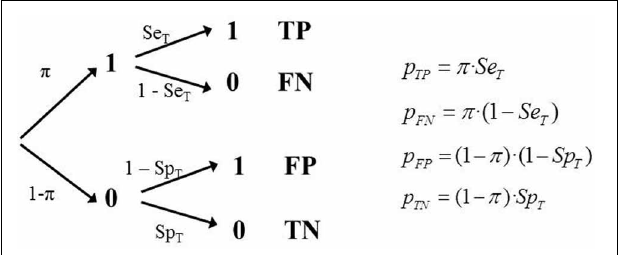
FIGURE 2 | Tree diagram of Model 1 (GS) and the corresponding